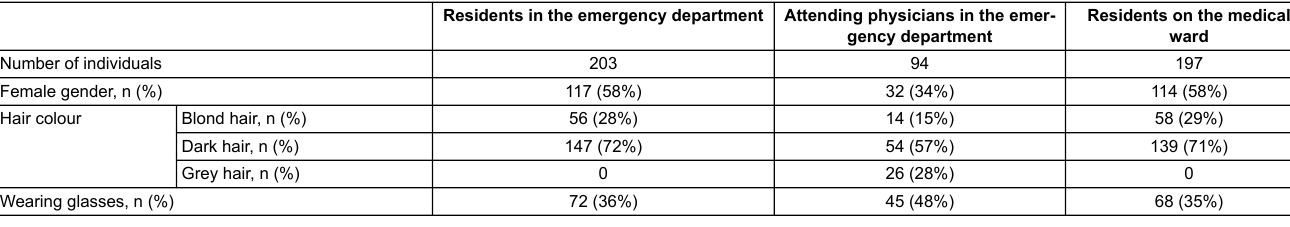
Table 2: Physical appearance of treating physicians at the emergency department and the medical